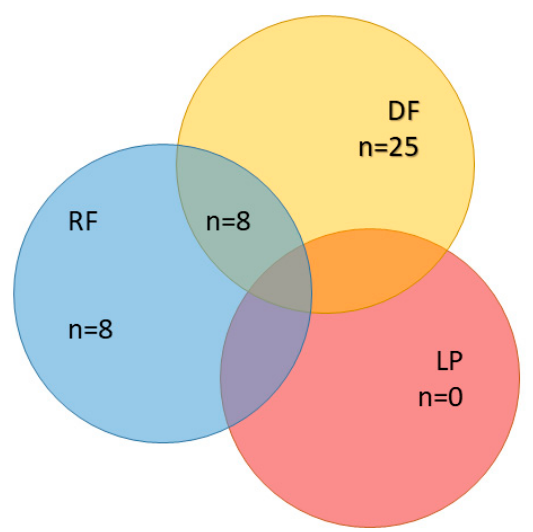
Figure 4. First tumor-related clinical event (per patient, n = 63), no event: n = 15, ADT as first tumor-related clinical event: n = 7 (not considered). ADT: androgen deprivation therapy, RF: regional failure; LP: local progression, DF: distant